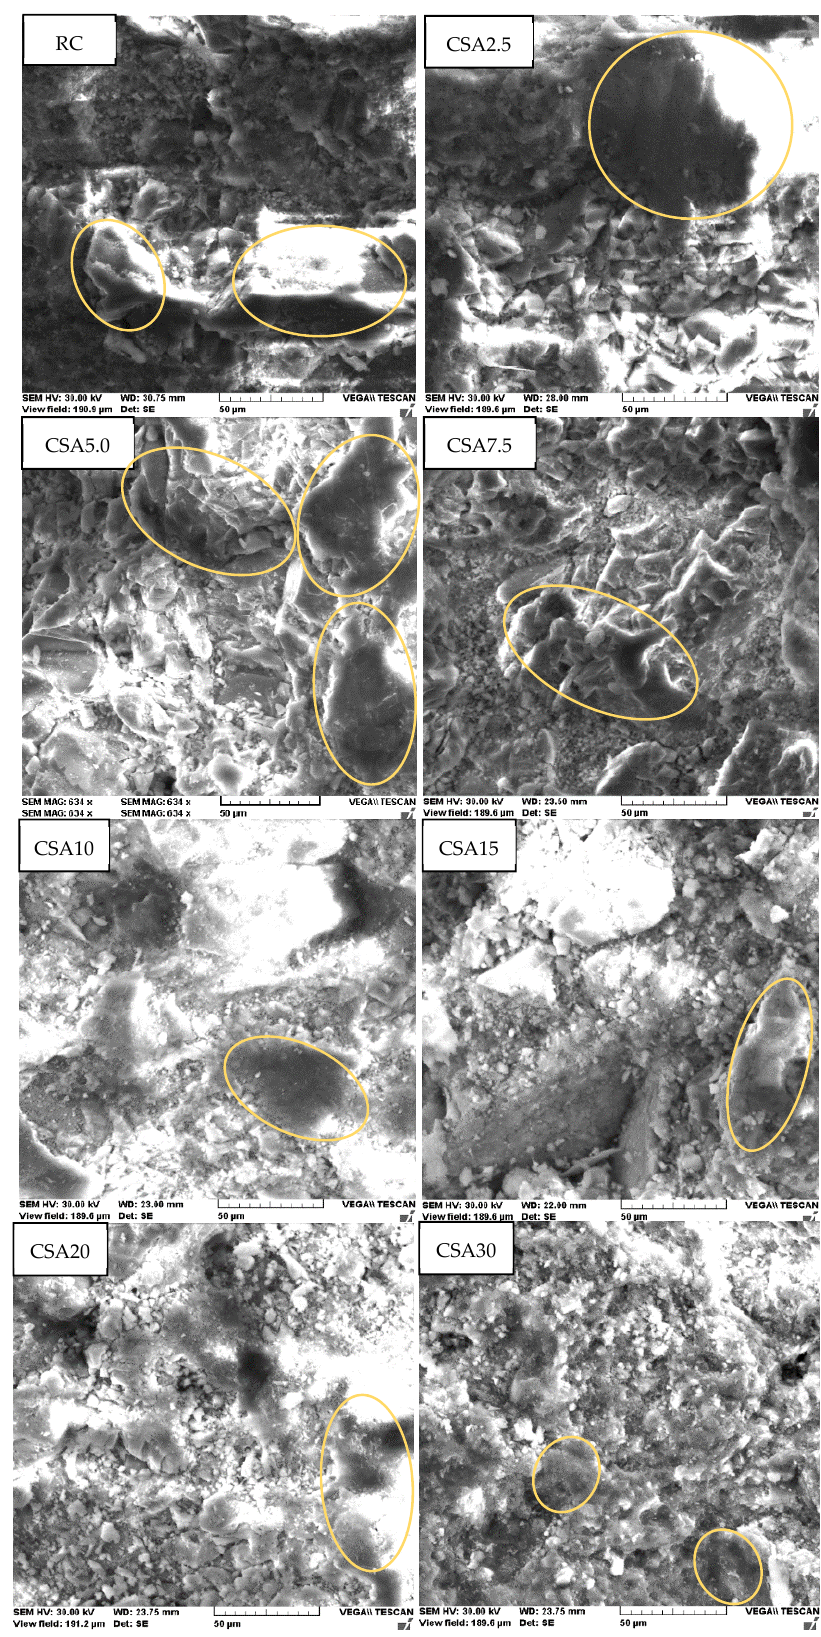
Figure 7. SEM images at a 50 µ m magnification rate of the studied cement-based composites. In Figure 8 are presented the chemical elements of the studied mixes.